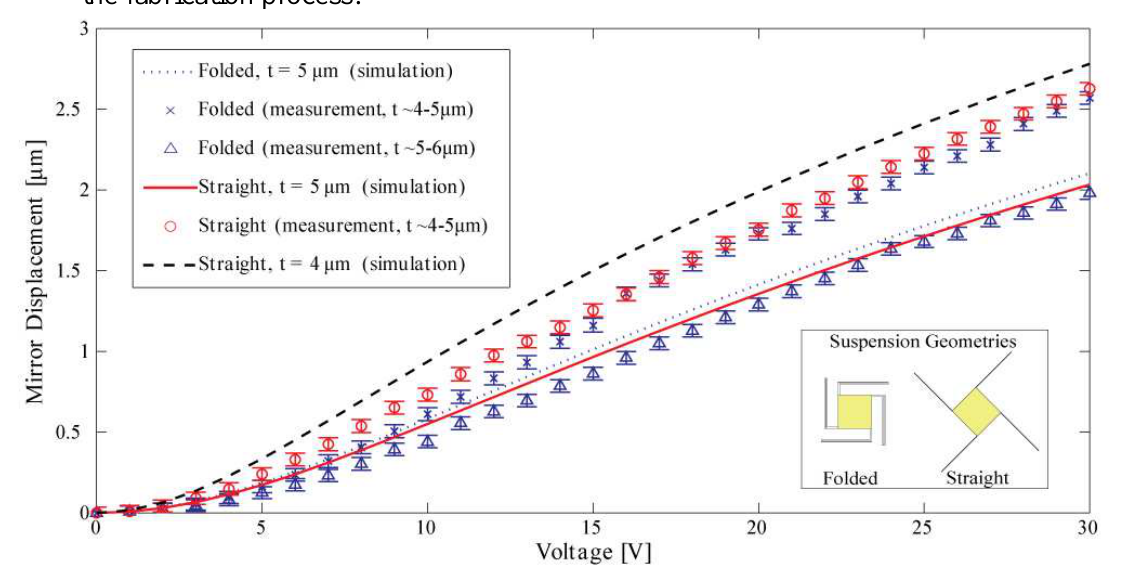
Figure 7: Simulations and measurements of mirror displacements for actuation voltages applied at all comb drives simultaneously. The discrepancies between the theoretical and measured curve have their origin in thickness variations of the suspensions due to the fabrication process.